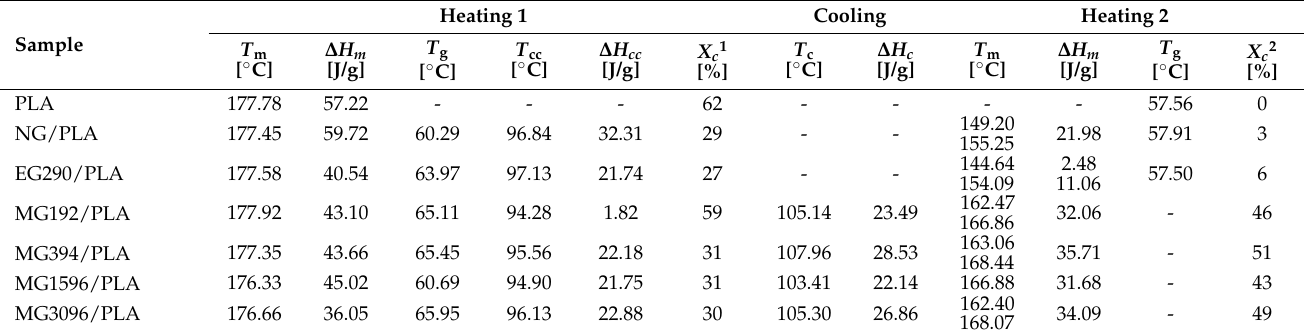
Figure 4. DSC analyses of graphite/PLA composites: ( a ) first heating, ( b ) cooling, ( c ) second heating. Table 3. Thermal data obtained by DSC for graphite/PLA